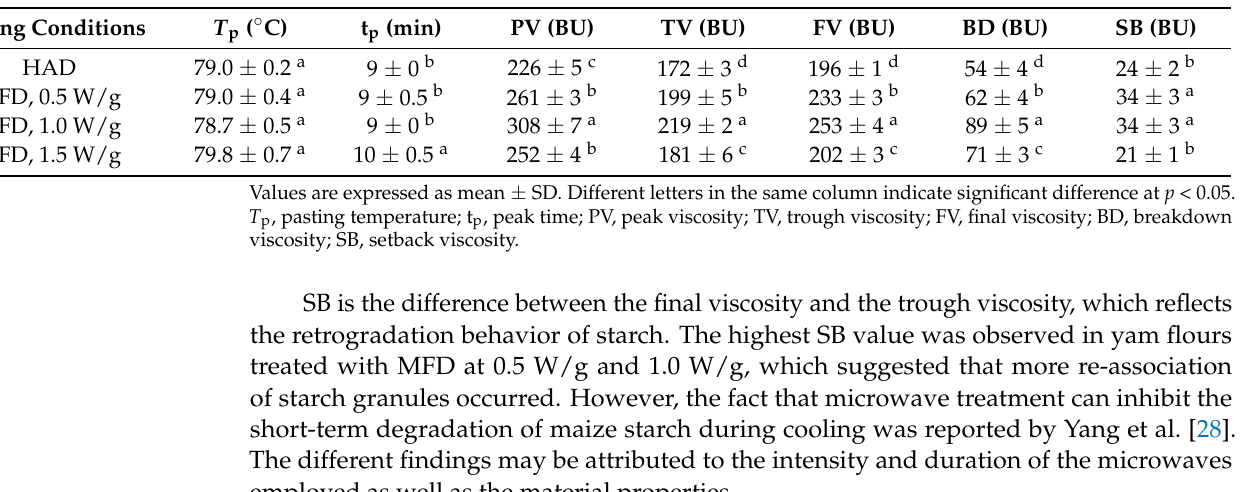
Table 3. Pasting properties of yam flours prepared by HAD and MFD.